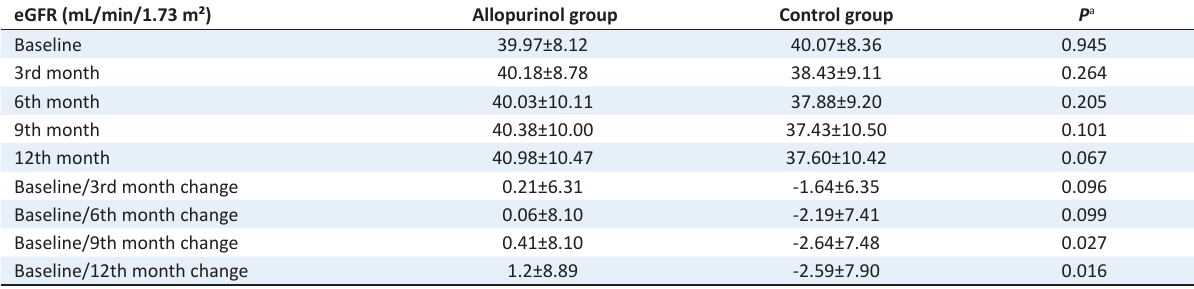
Table 2. eGFR change in allopurinol and control group eGFR (mL/min/1.73 m²)